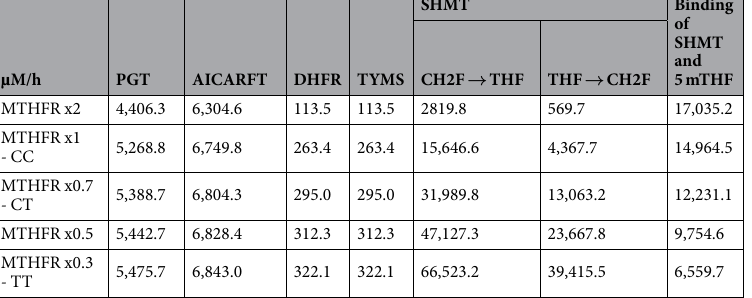
Table 4. Fluxes of the reactions catalyzed by the enzymes PGT, AICARFT, DHFR, TYMS, SHMT and the unbinding of 5mTHF and SHMT for different levels of MTHFR activity (ranging from 2x to 0.3x of wild type). CC, CT and TT refer to the C667T polymorphism.